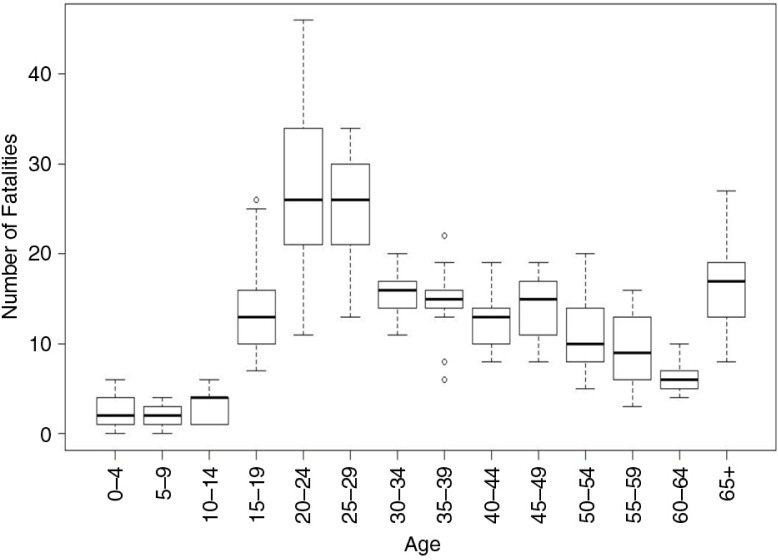
Boxplot of road fatalities by age from 2000 to 2011.